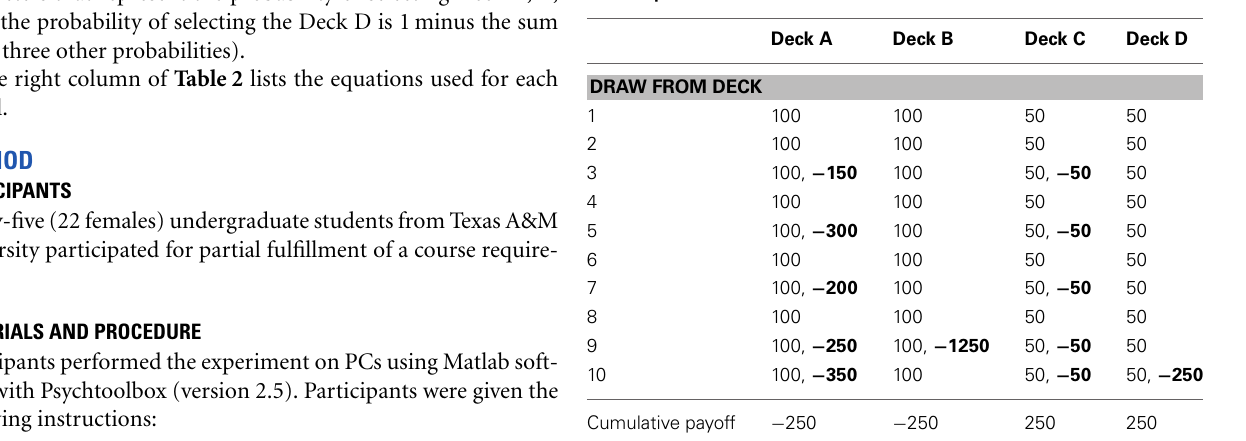
Table 1 | Reward schedule for the IGT.